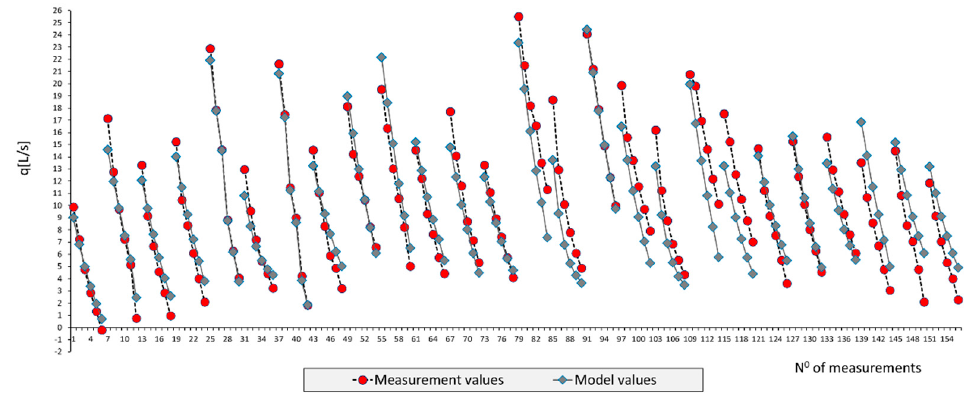
Figure 6. Measured and predicted values of HT total water losses for the LDS, for the period 2005– 2015.